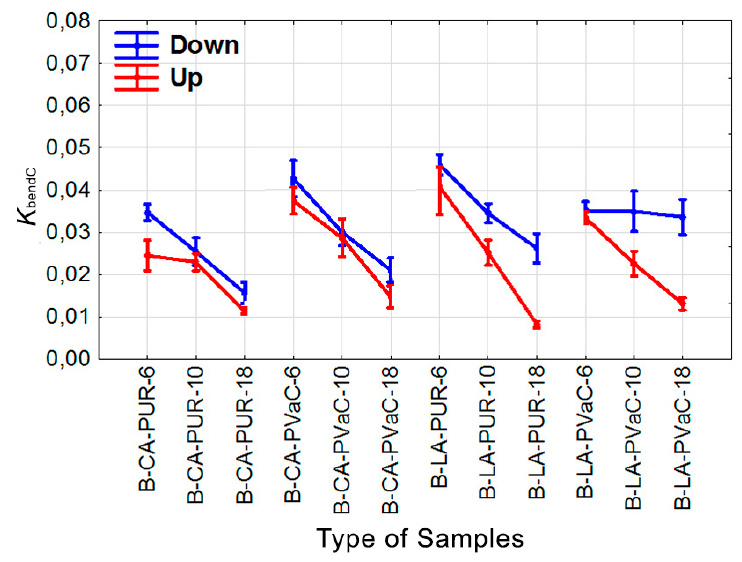
Figure 5. K bendC in case of beech.